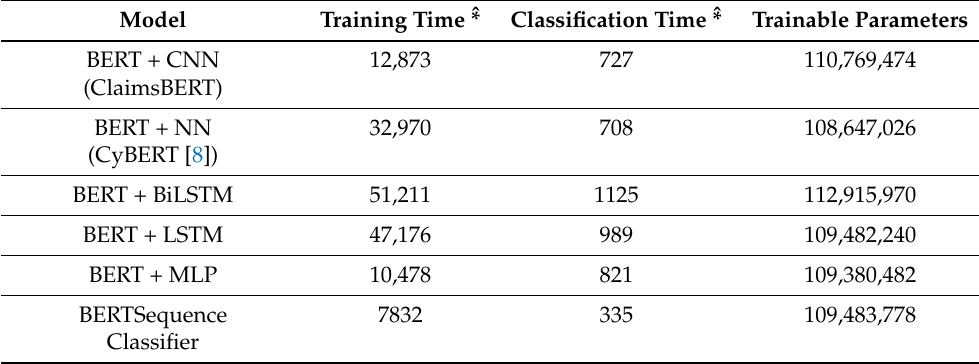
Figure 11. Comparing training accuracy ( left ), validation accuracy ( right ) for all tested models. Table 9. Comparing ClaimsBERT and other tested models